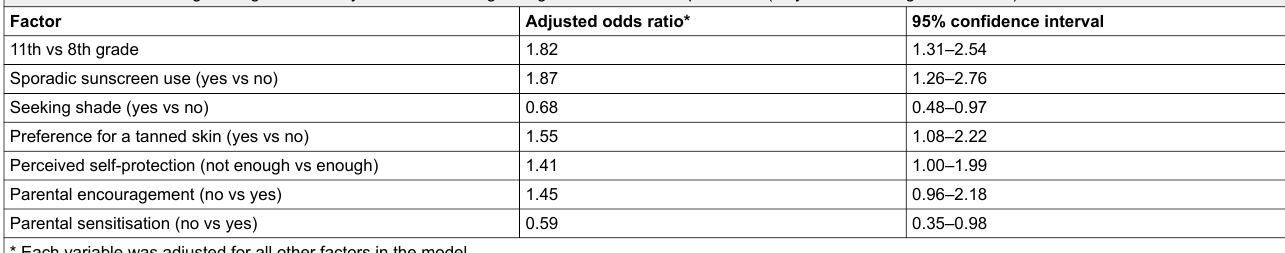
Table S2: Multivariate logistic regression analysis for not wearing a long-sleeved shirt as a protection (only 8th and 11th graders